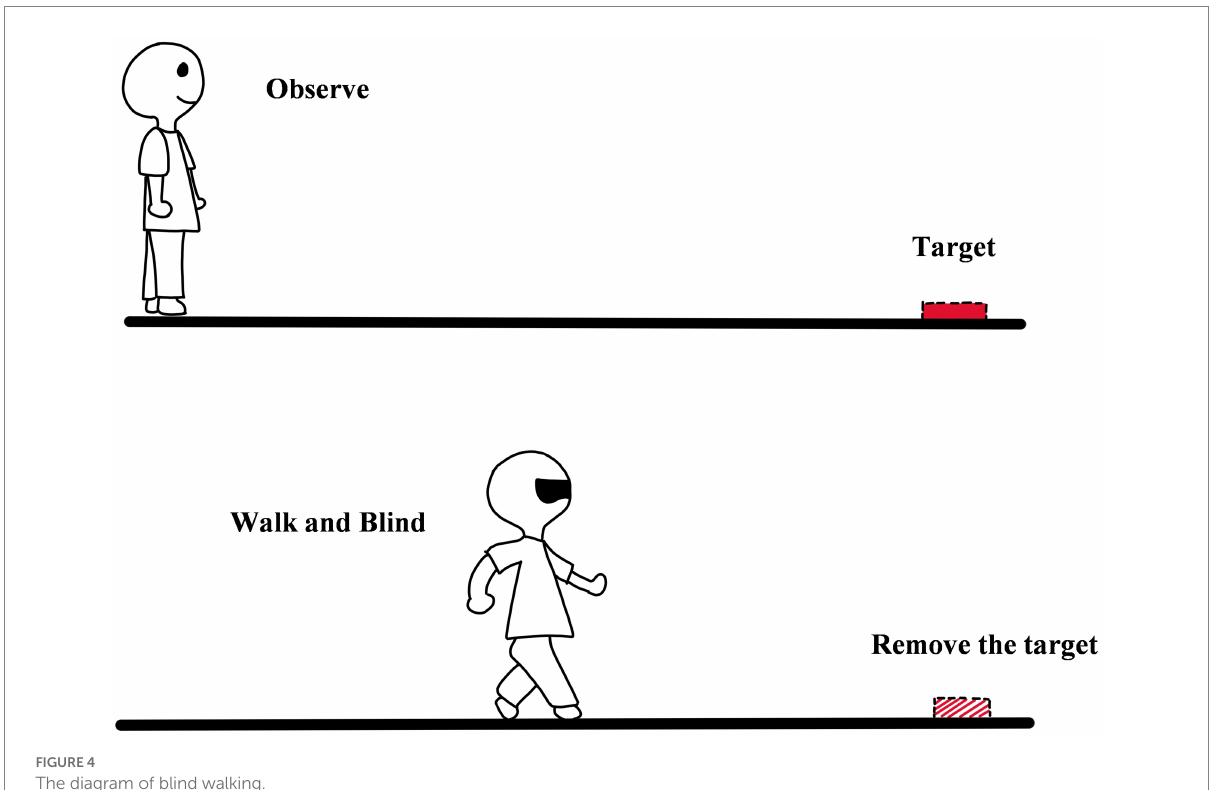
FIGURE 4 The diagram of blind